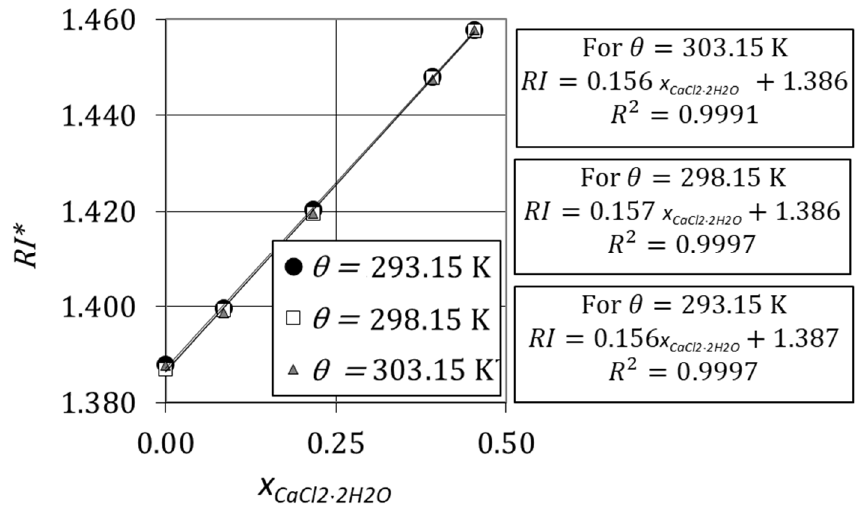
Figure 8. Variation of refractive index of aqueous solutions x 0,glycerol = 0.41 with the mass fraction of CaCl 2 ·2H 2 O.